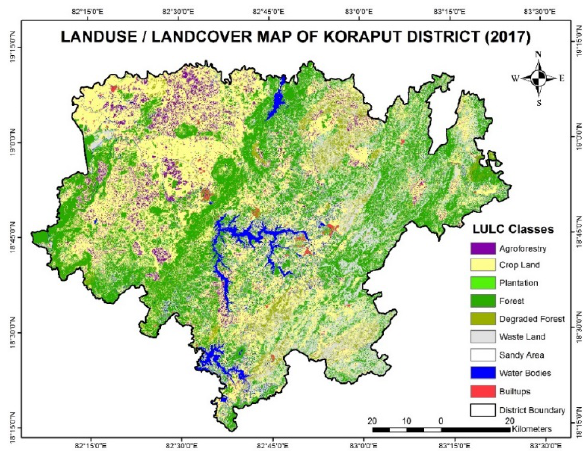
Figure 2. Land use/ land cover map of Koraput